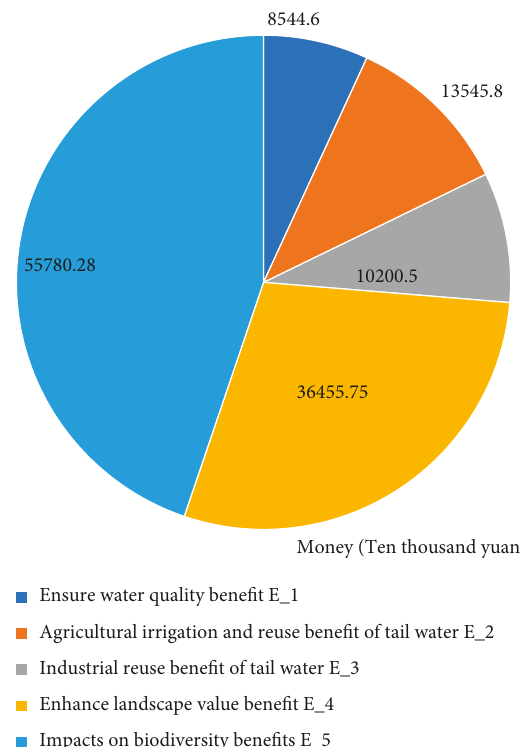
Figure 1: Tail water diversion engineering environment affecting economic profit and